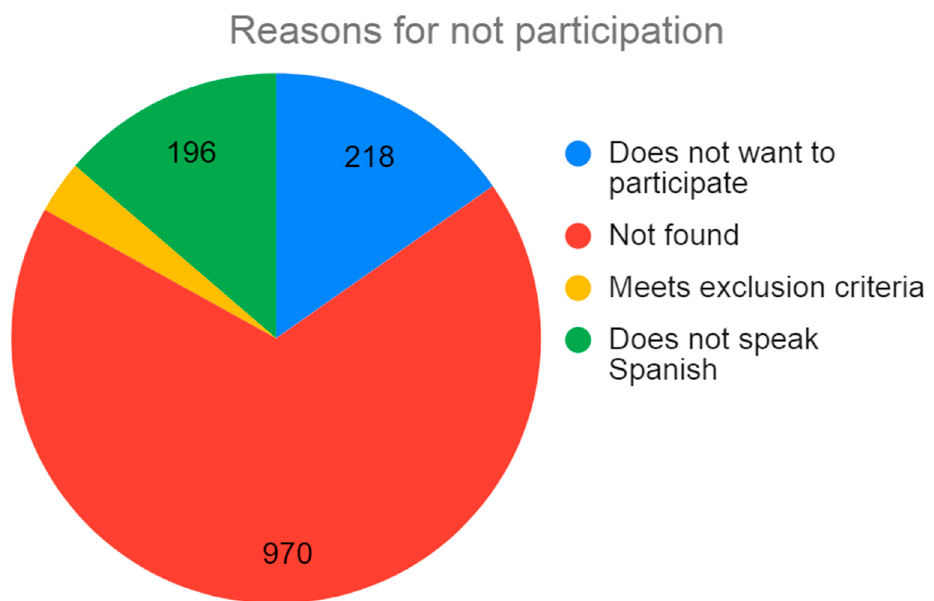
Figure 3. Distribution of non-participation reasons .